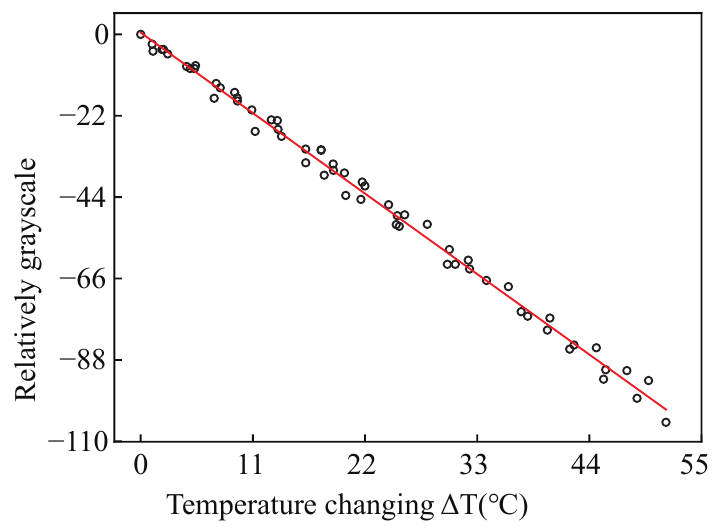
Figure 4. The coefficients of c and d can be obtained from the line: c = 0.27733304 and d = 1.9669431. −